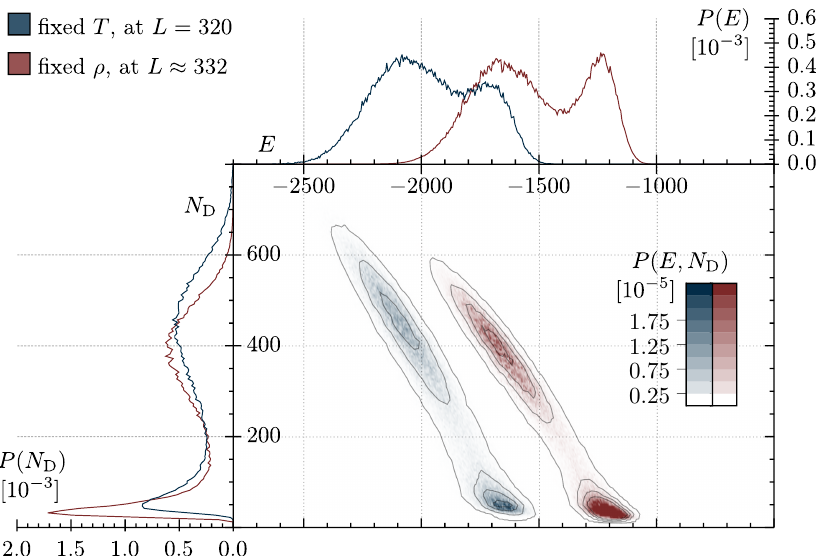
Figure 10: Comparison of probability distributions at the finite-size transition points – obtained via N (cid:48) – for the droplet formation-dissolution transition at fixed tempera- D ture (blue) and fixed density (red). The two-dimensional distribution P ( E , N respect to both reaction coordinates E and N can be projected along either axis to D ) on the left, or P ( E ) on the obtain P ( N D